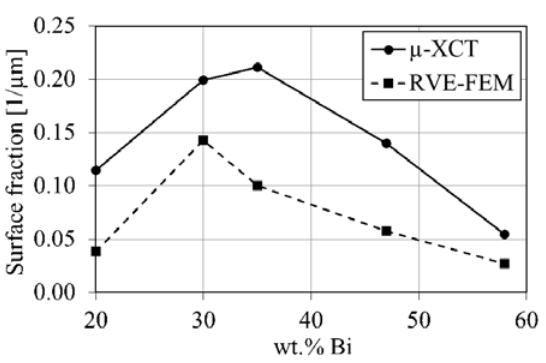
Figure 11. Eutectic surface fraction over composition from µ -XCT (solid) measurements and RVE-FE (dashed)